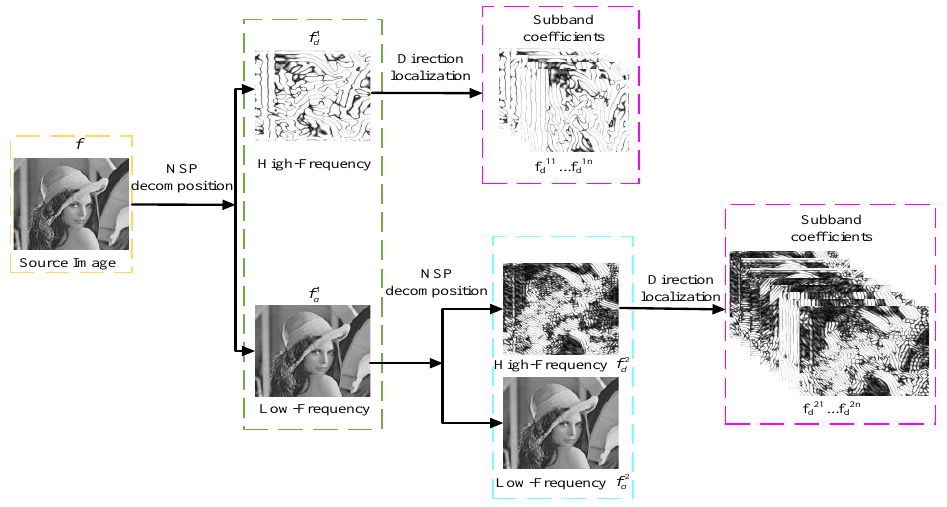
Figure 1. NSST decomposition structure with two